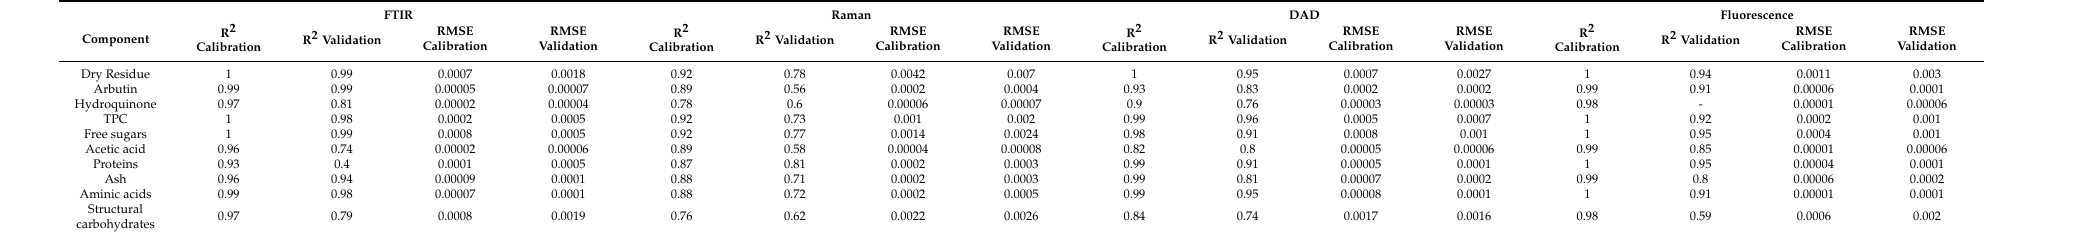
Table 1. Overview of Calibration and Validation R 2 and RMSE for each component group and spectroscopic